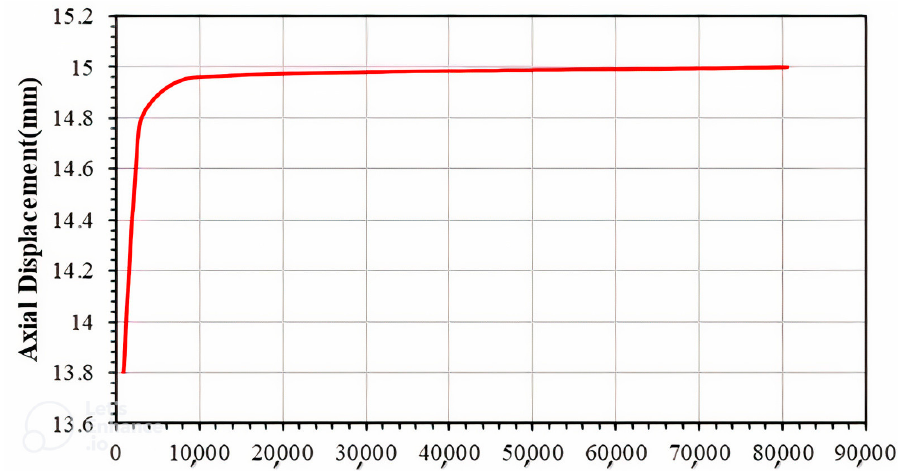
Figure 6. The change in axial displacement.